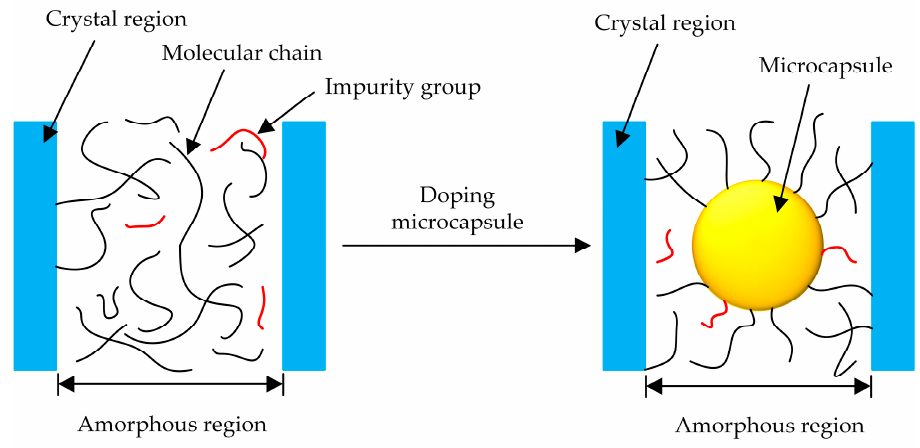
Figure 10. Anchoring effect of microcapsule in polyethylene.